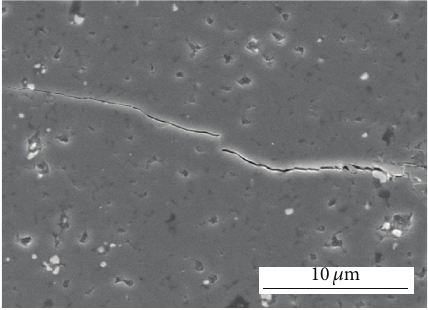
Figure 13: Higher magnification showing the toughening mecha-